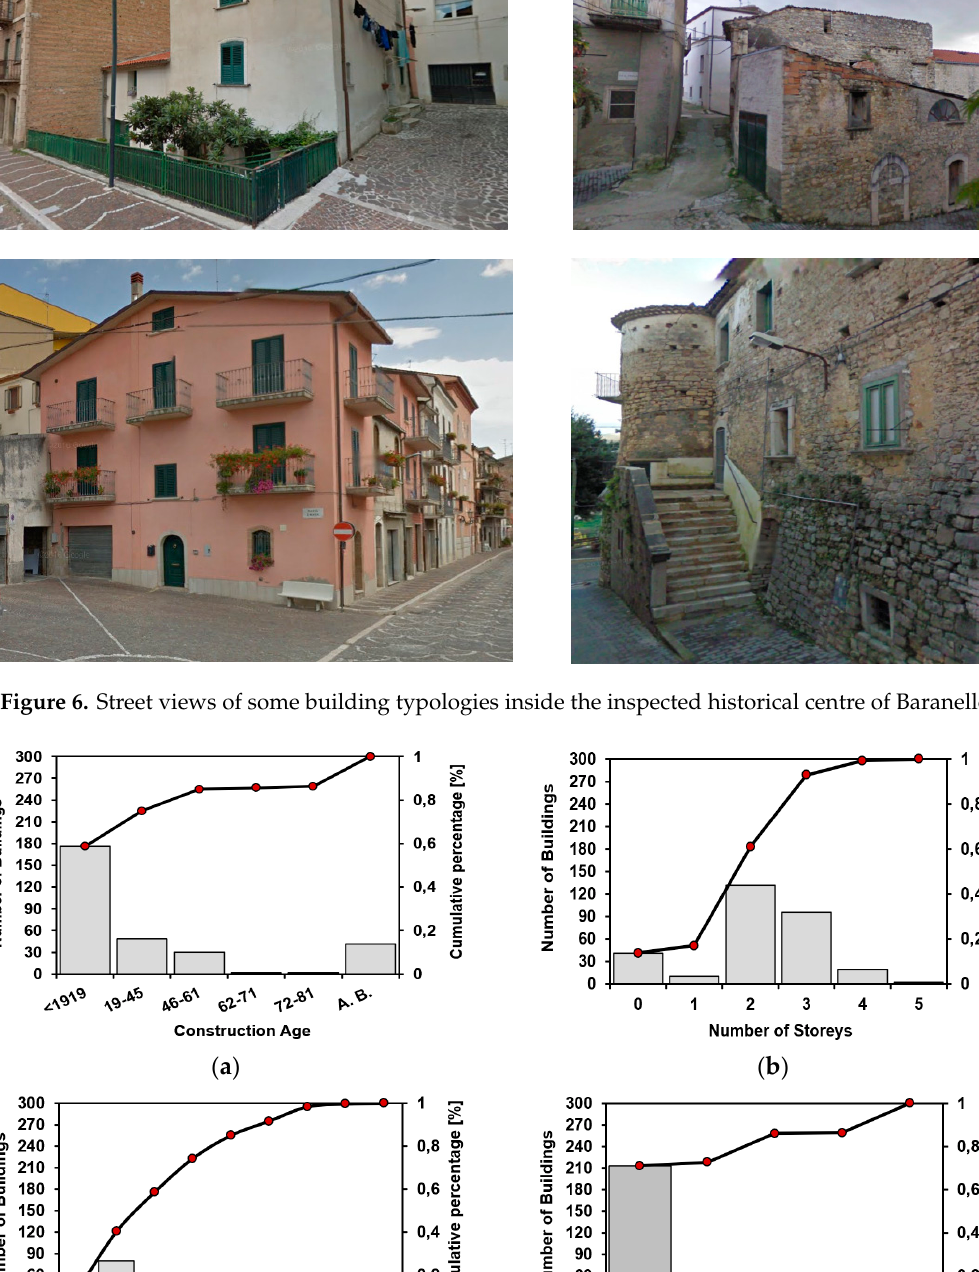
Figure 7. Preliminary characteristics of buildings surveyed in the municipality of Baranello.